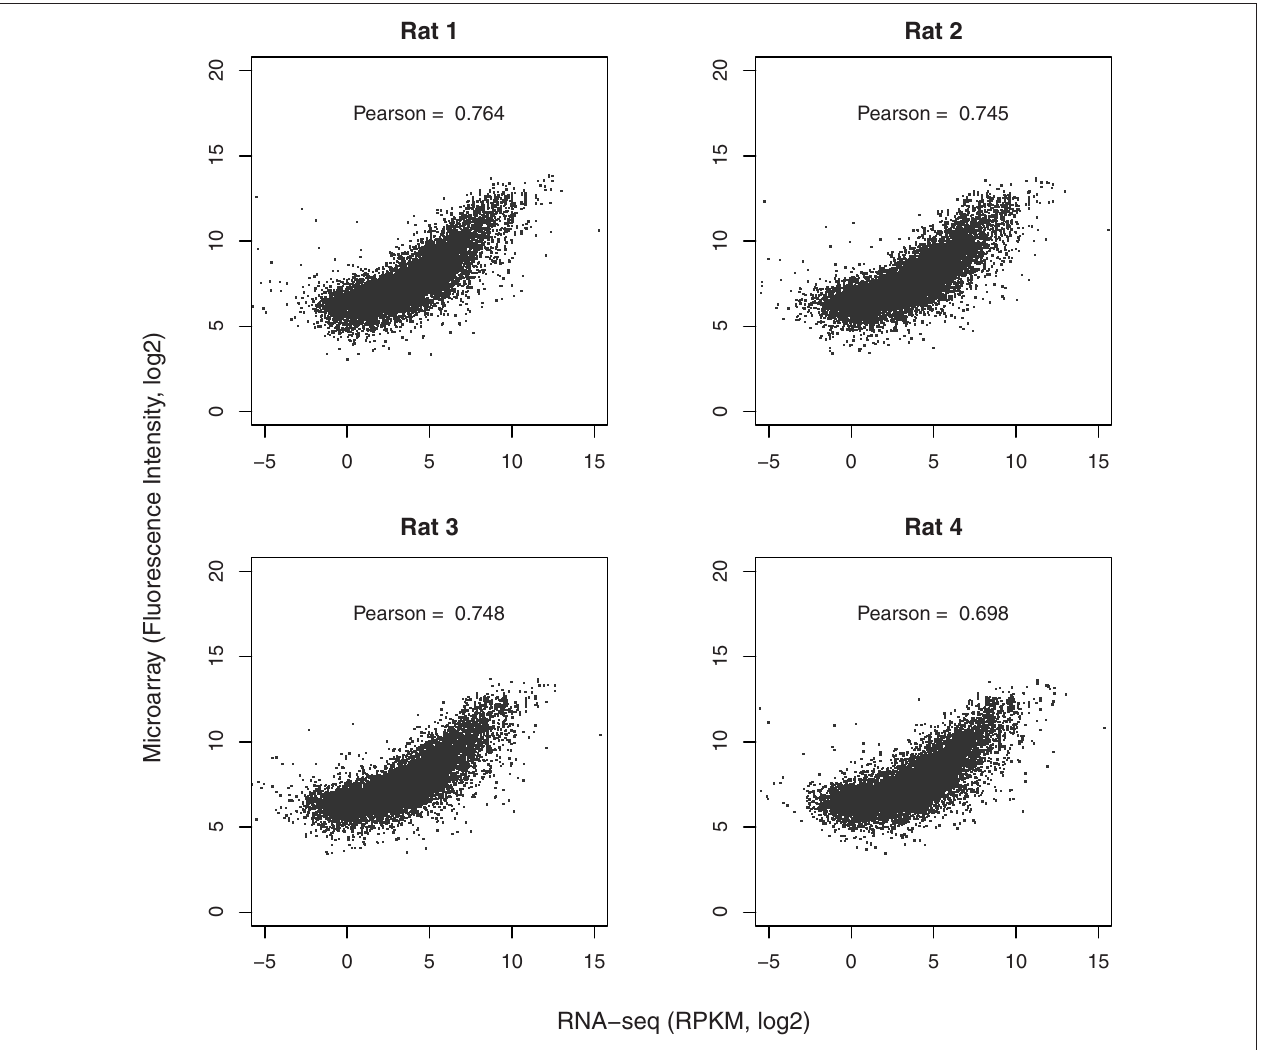
those expressed at lower abundance levels. More importantly, the dynamic range of RNA-seq is much higher than that of microarray (from − 4 to 10 vs from 5 to 15 on log scale for RNA-seq and microarray, respectively, representing ∼ 2–3 orders 2 of magnitude in difference). This enhanced dynamic range is likely to provide better accuracy in detecting the differences between samples or